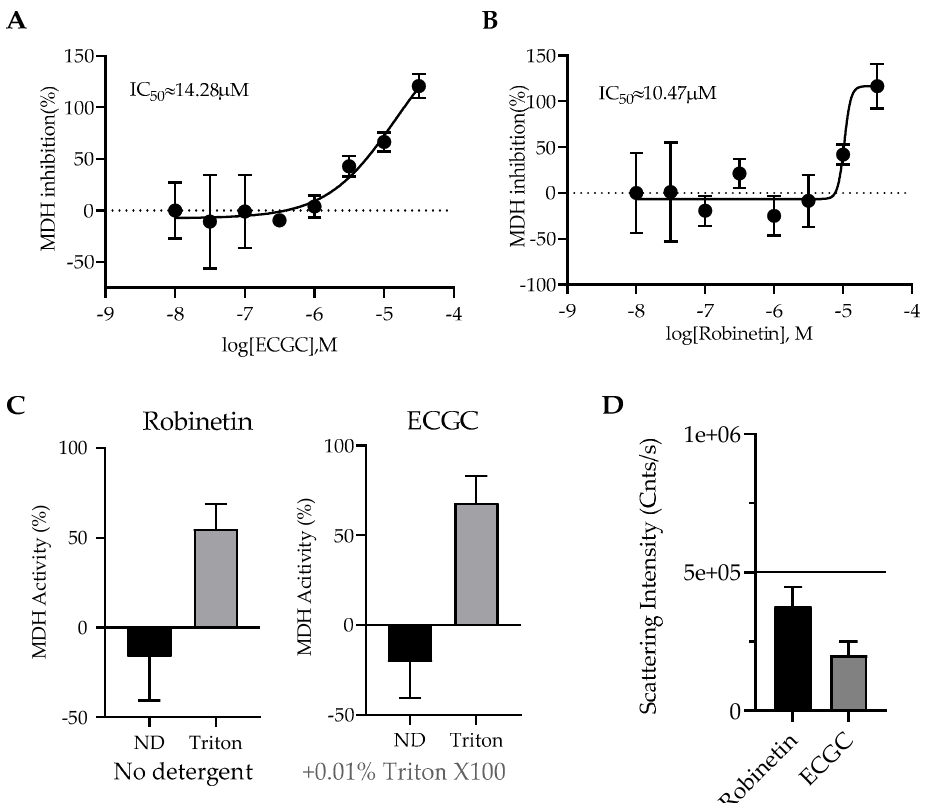
Figure 10. Aggregation assays. Malate dehydrogenase (MDH) enzymatic screen for ECGC ( A ) and robinetin ( B ). ( C ) Malate dehydrogenase (MDH) enzymatic activity with or without 0.01% Triton X-100 at 31.6 µ M. ( D ) Scattering intensity of compounds ECGC and robinetin that do not form colloidal-like particles measured by DLS at 31.6 µ